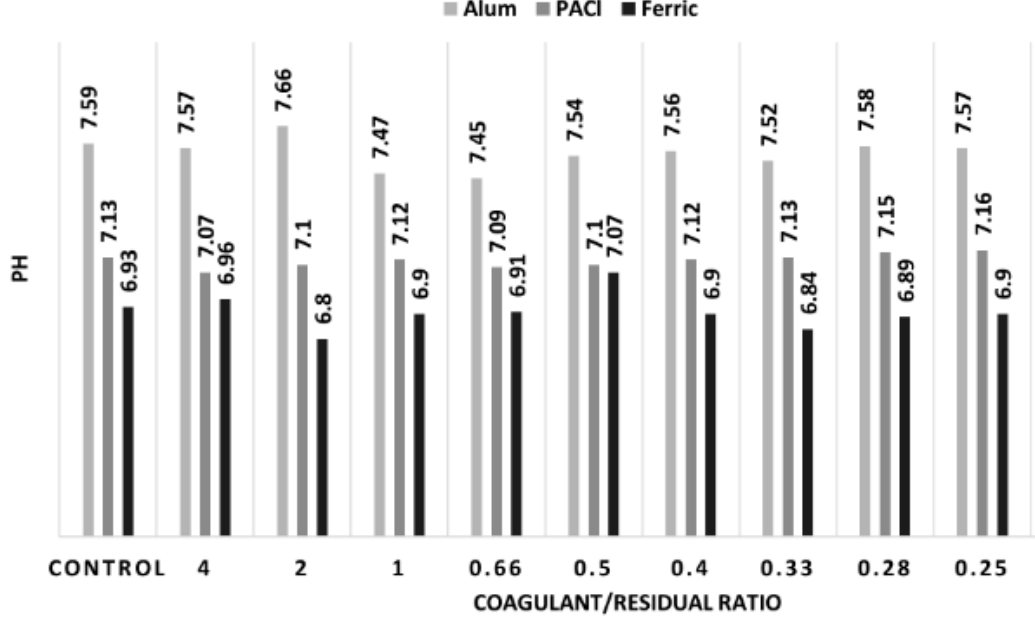
Figure 6. pH change because of treatment with residuals .